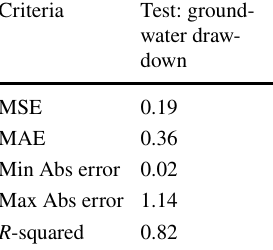
Table 4 Performance evaluation of the CANFIS network in the testing stage